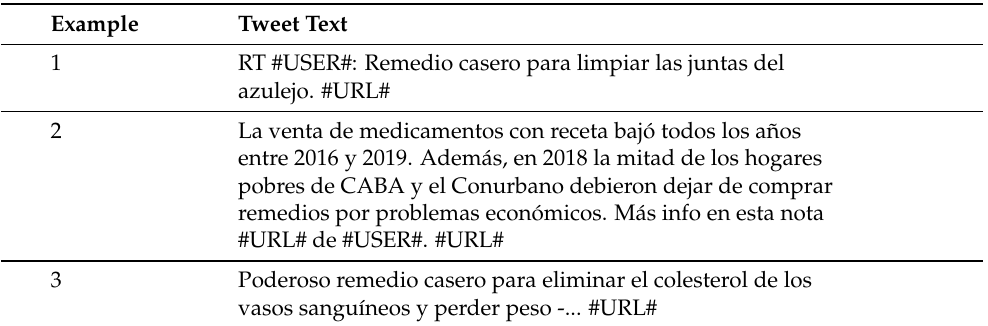
Table 6. Examples drawn from the nFNS Spanish test